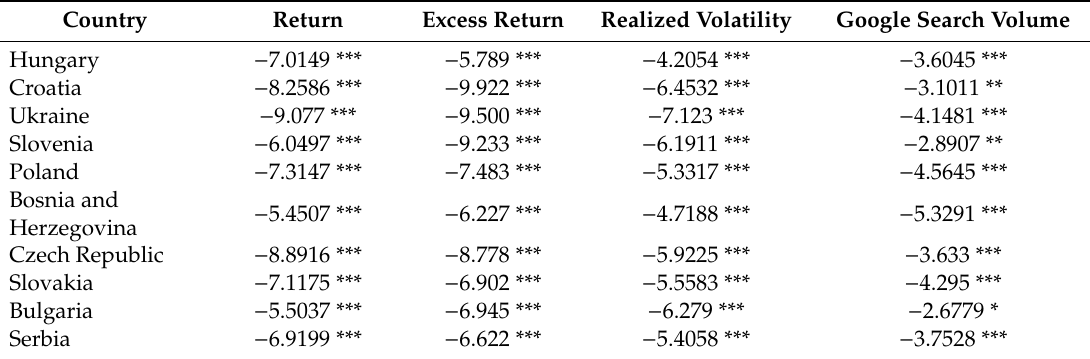
Table A1. Unit root test results for variables, constant included.